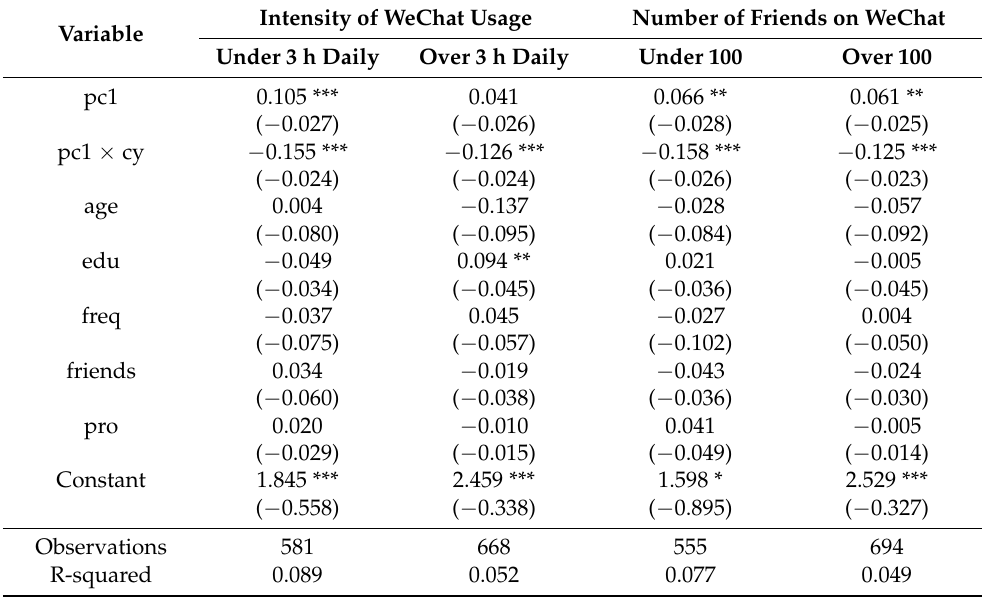
Table 10. The heterogeneity analysis of usage